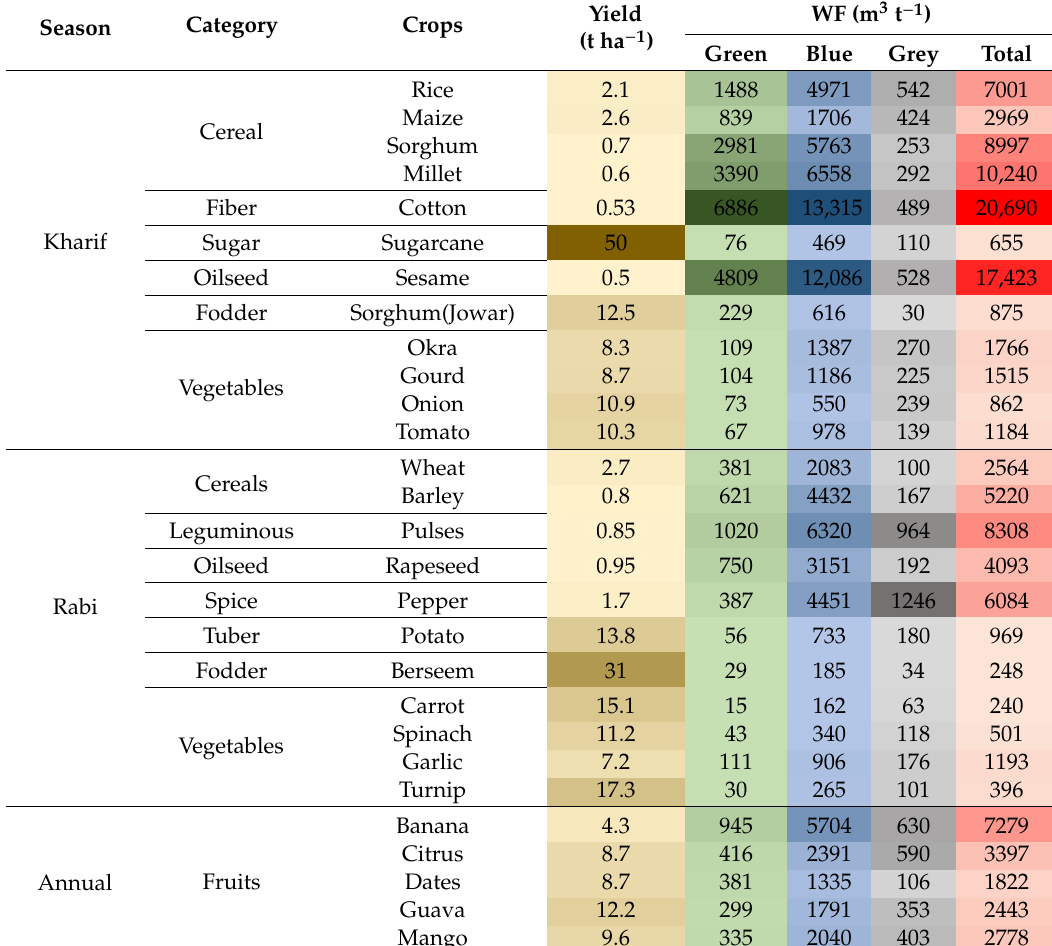
Table 2. Average yield and water footprint (WF) for crops in both cropping seasons in the Indus basin for the period